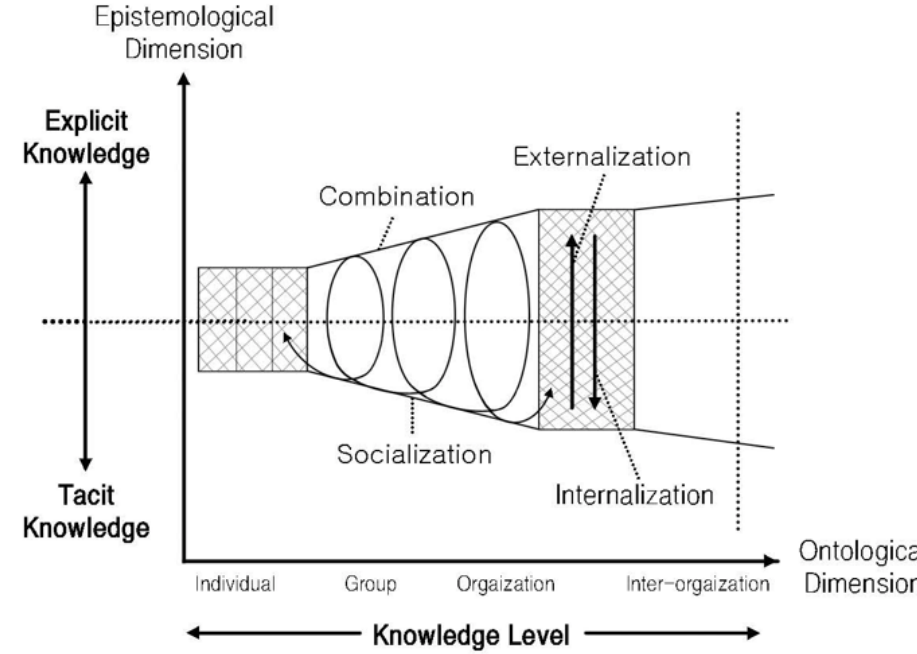
Figure 4. Spiral of knowledge creation (by Nonaka